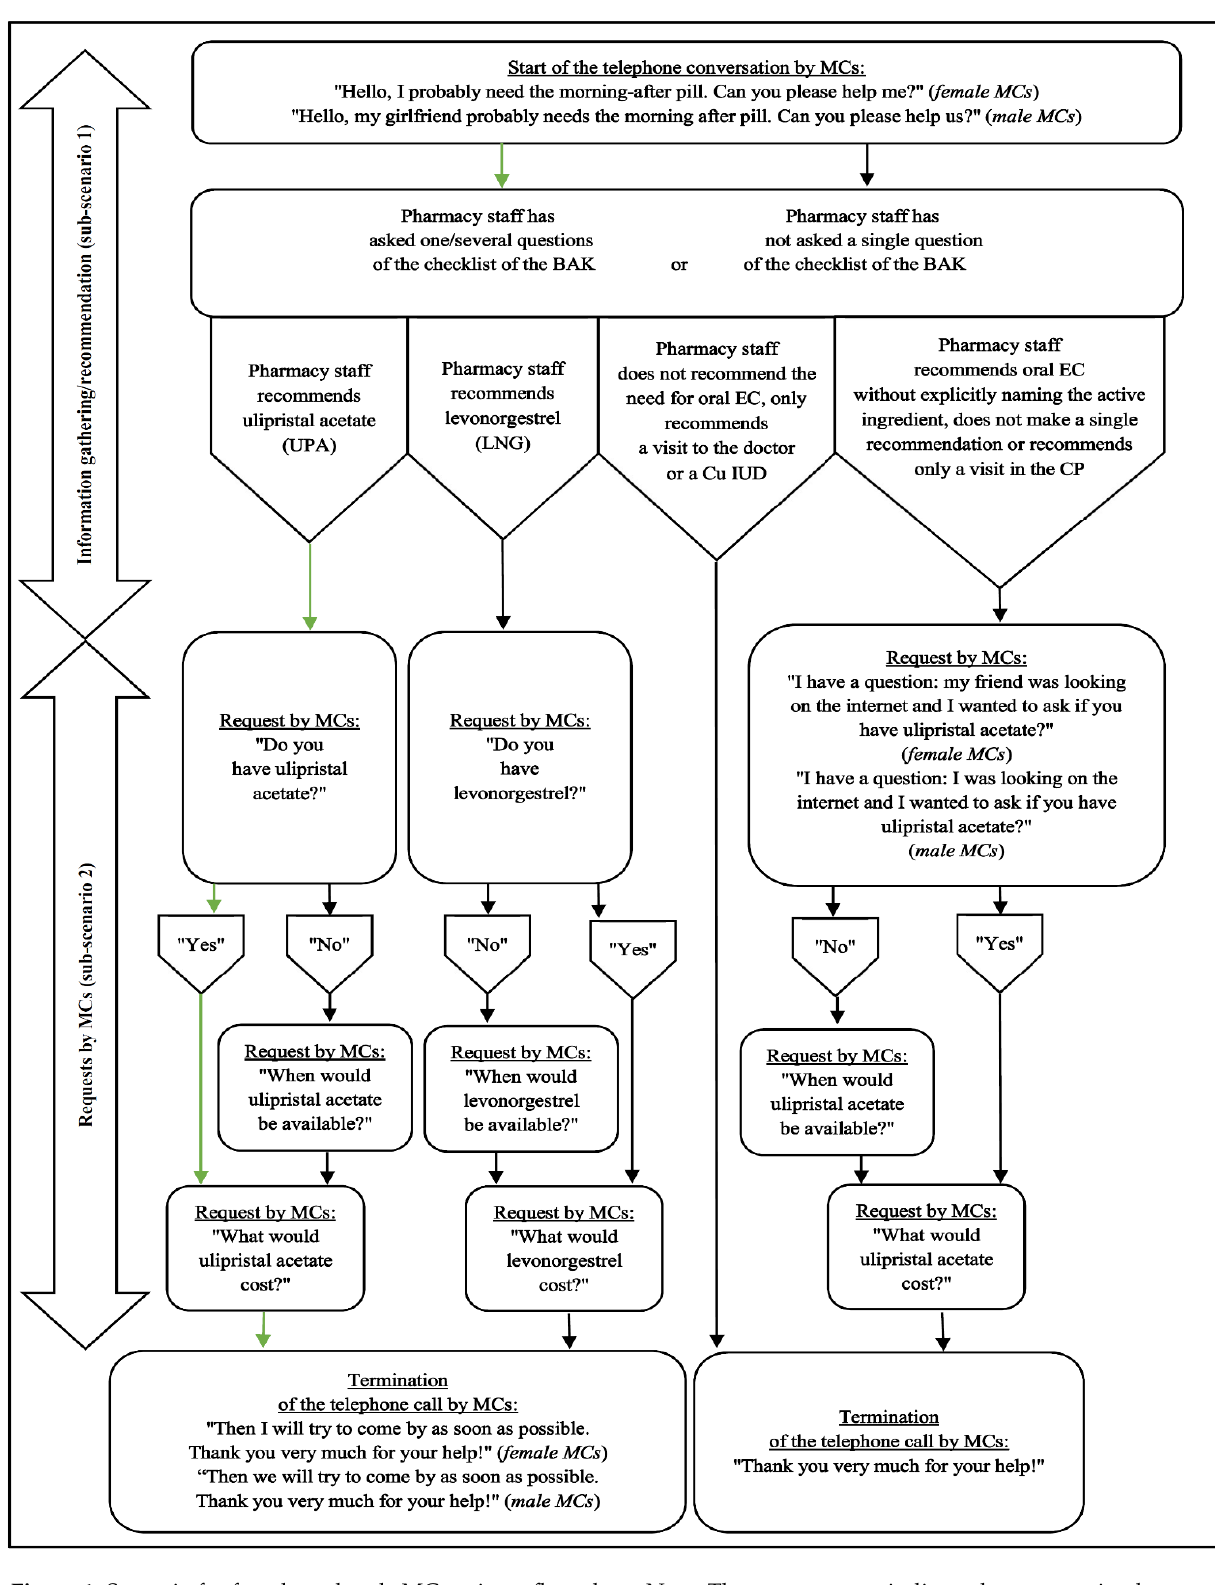
Figure 1. Scenario for female and male MCs using a flow chart. Note: The green arrows indicate the most optimal course of conversation.